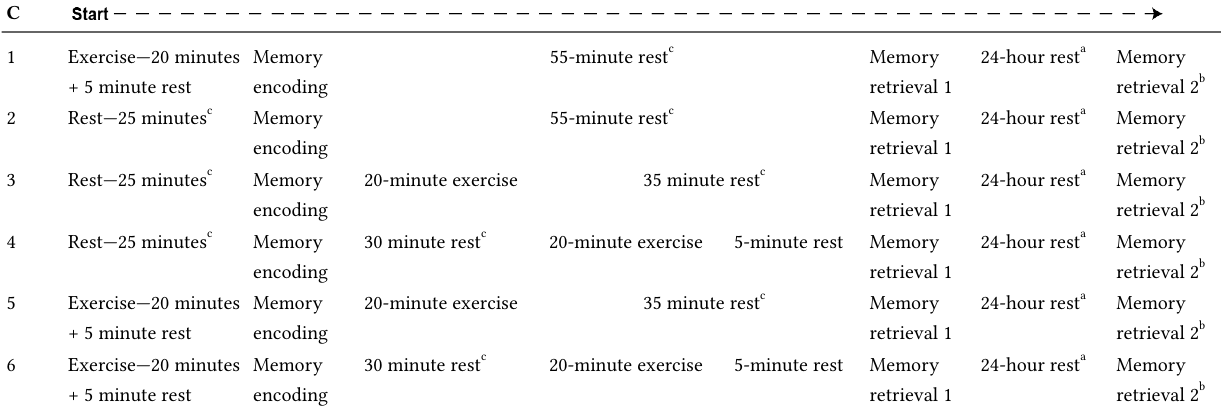
Study Protocol for Experiment